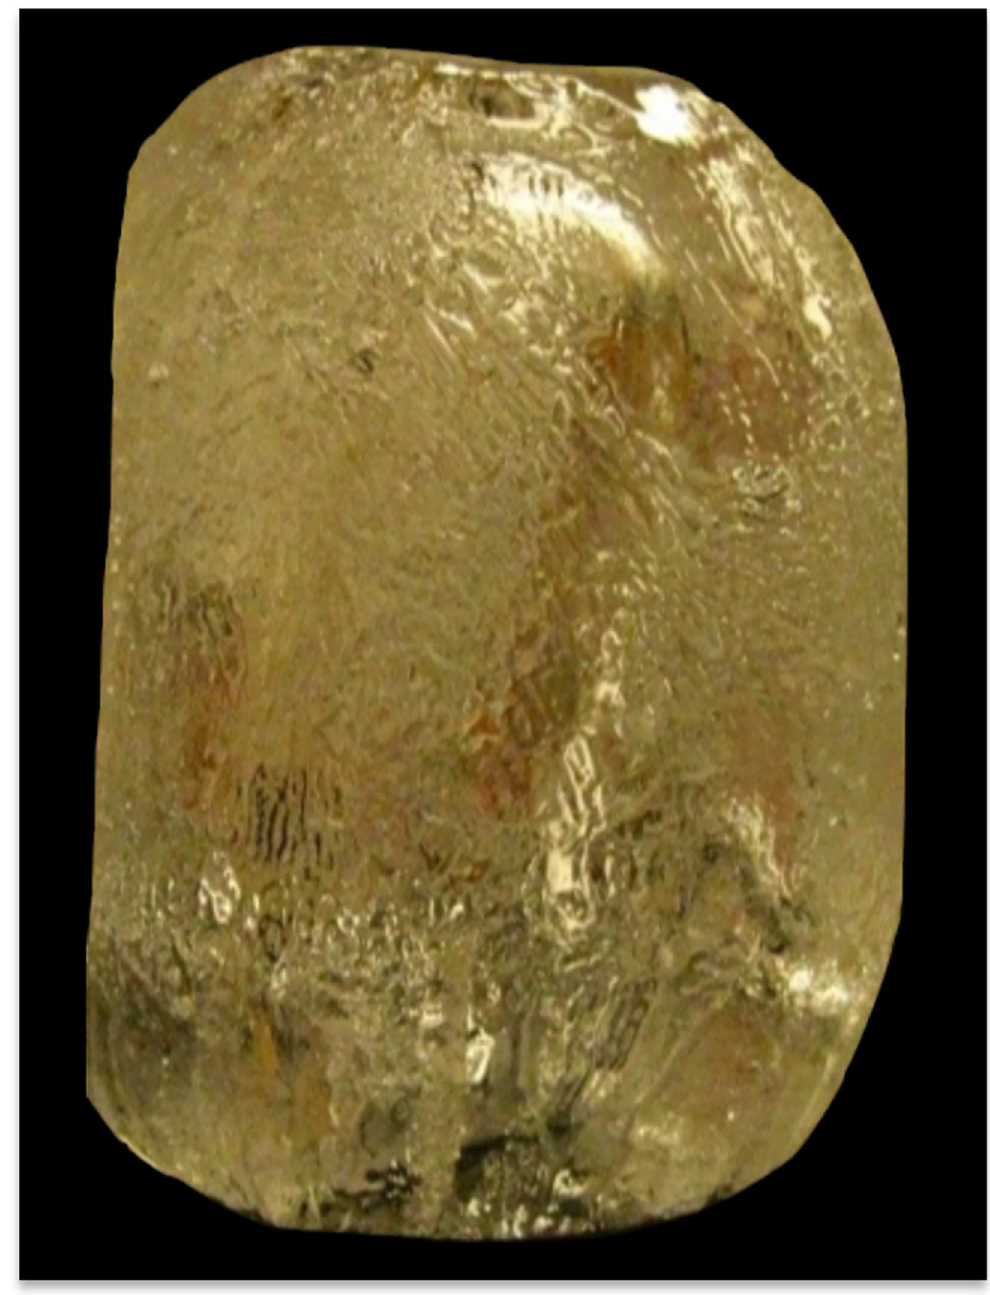
Fig 4. Representative ice hemisphere obtained during the ice-affinity purification of native Bd IRI proteins. The polycrystalline ice hemisphere shown was obtainedafter two rounds of ice-affinity purification using crude cell lysates of cold acclimated(1 week at 4˚C) wild-type B . distachyon leaf tissue (20 g). The ice etchingobserved across the surface of the ice hemisphereindicatessuccessful incorporation of IBPs. The procedurewas conducted in